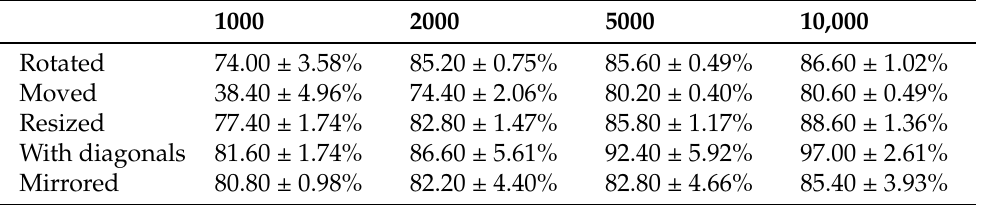
Table 7. The number of transformed objects: 8; Level of noise: 2.